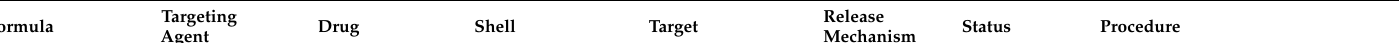
Table 8. Examples of application of SIONPs in Drug Delivery and imaging in single